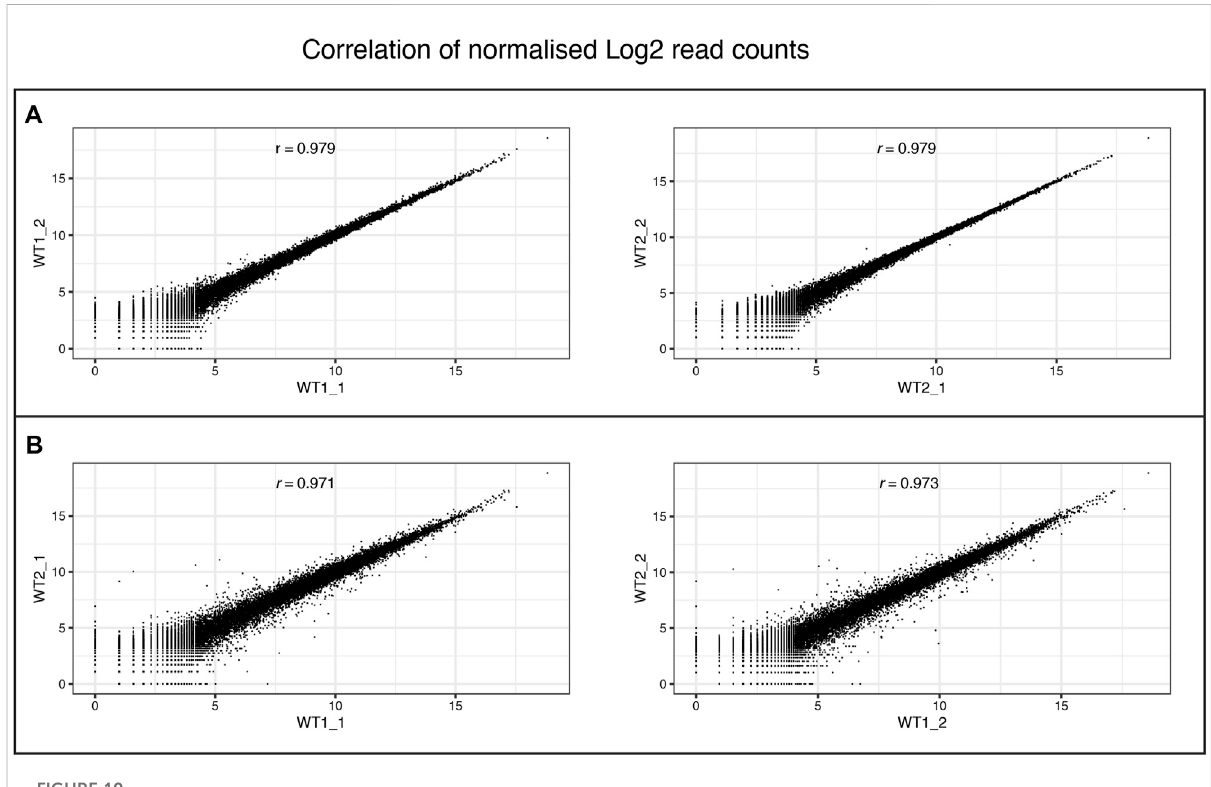
FIGURE 10 Consistency of RNA-Seq replicates. Correlation between levels of gene expression (normalised Log2 counts) of (A) differentiation replicates (_1and _2) of individual wildtype clones (WT1 and WT2), and (B) between different wildtype clones within the same differentiation batch. Pearson correlation scores are provided for each